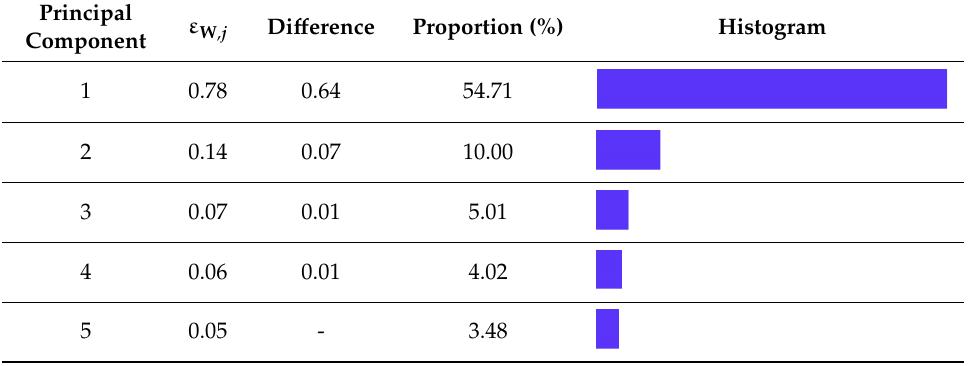
ε ε Table 2. The first five W, j obtained by VBPCA algorithm for the north component. ε Table 2. The first five W, j obtained by VBPCA algorithm for the north component. ε Table 2. The first five W, j obtained by VBPCA algorithm for the north component. Table 2. The first five W, j obtained by VBPCA algorithm for the north component.